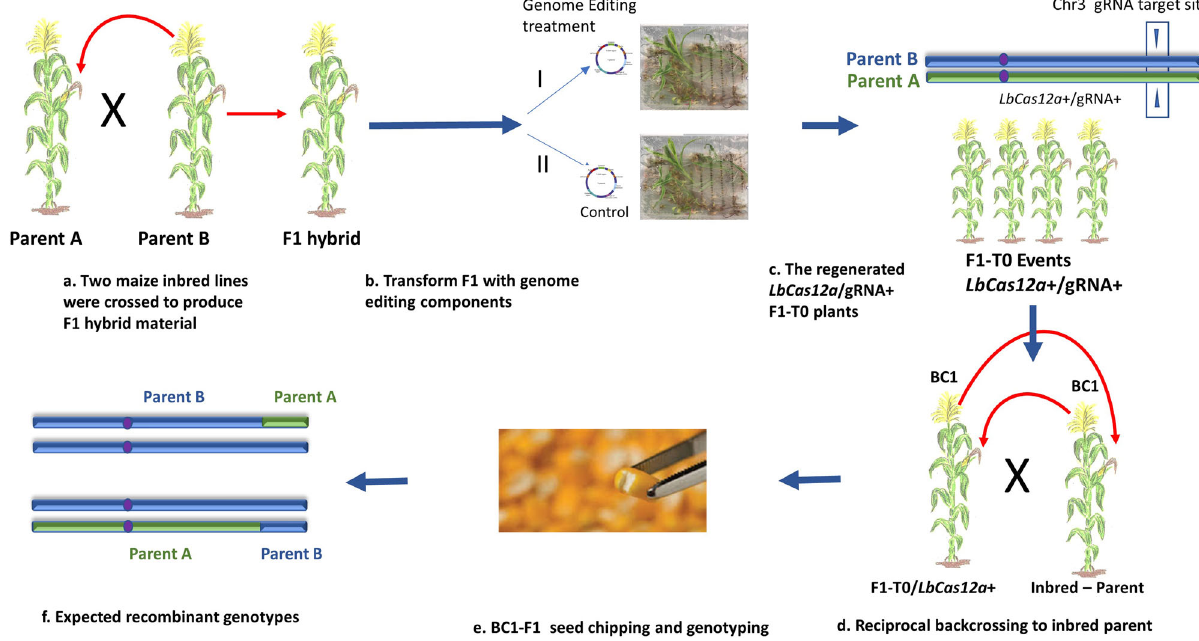
Fig. 2 Experimental work fl ow to demonstrate guided homologous chromosome recombination in maize. a Two maize inbred lines were crossed to produce F1 hybrid material. b Isolated F1 embryo explants were separated into two groups for Agrobacterium -mediated transformation: (I) editing treatment; (II) control treatment. c , d The regenerated F1-T0 plants were reciprocally backcrossed to Parent B (the fi rst experiment: gRNA1) or Parent A (the second experiment: gRNA2) for the identi fi cation of CO by genotyping. e The harvested BC1-F1 seeds were chipped to isolate a small amount of endosperm tissue for genotyping analysis using SNP TaqMan assays. f The genotyping results were examined for the presence of the expected reciprocal chromosomal recombination between the parental chromosomes. Table 1 Result of the genotyping analysis and identi fi cation of the BC1-F1 seeds with chromosomal recombination at the gRNA1 target